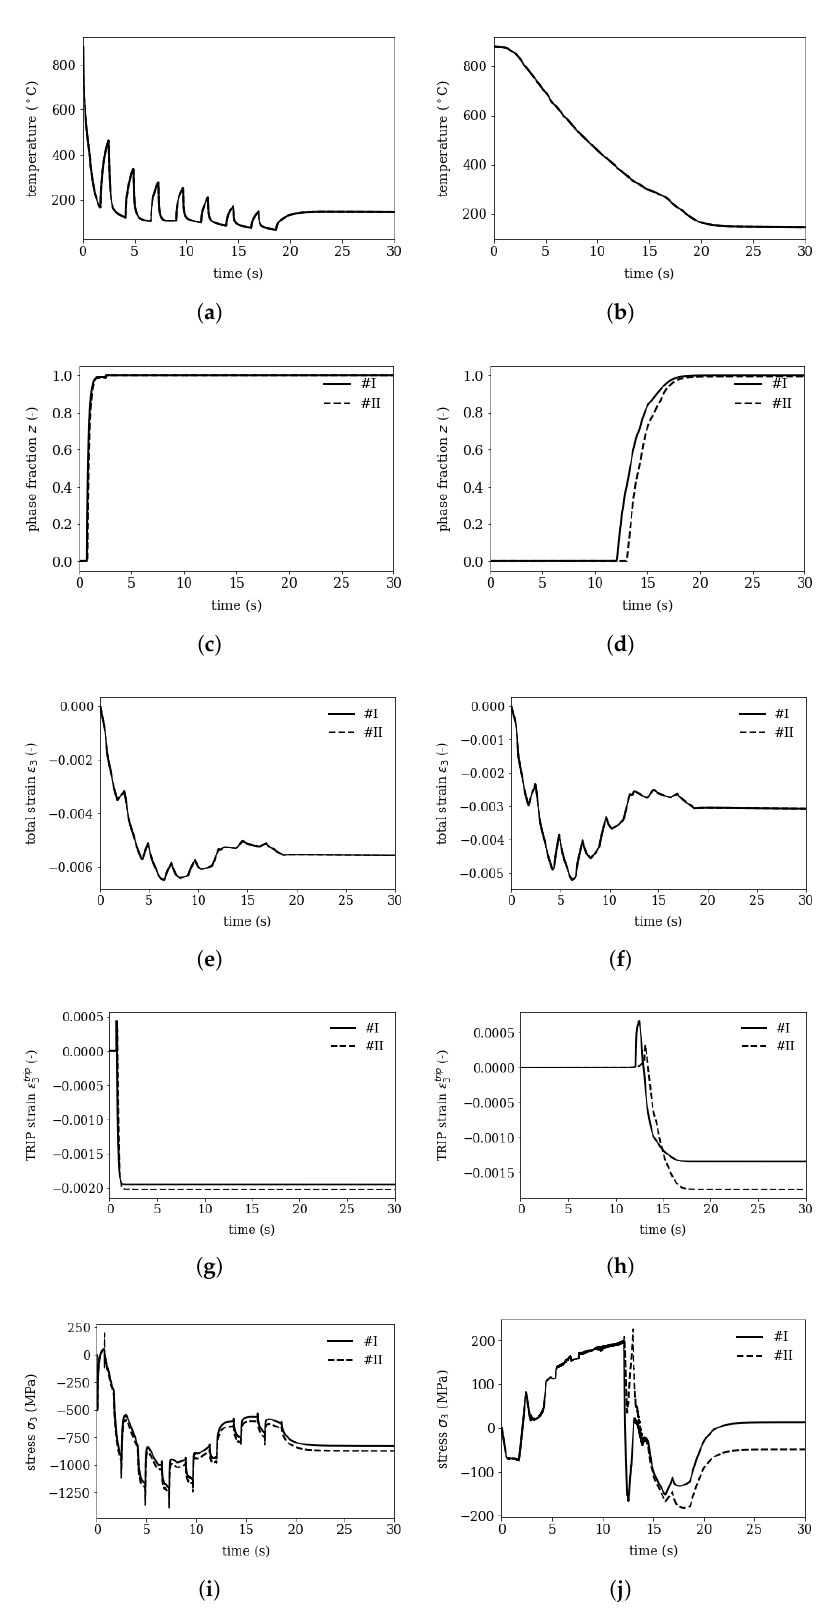
Figure 8. Results of mesoscopic submodel for (left) point 1 on the outer surface and (right) point 2 on the inner surface (see also in Figure 1): the temperature, phase fraction z , total strain in direction 3 (tangential direction in the macroscopic model), the TRIP strain and the resulting